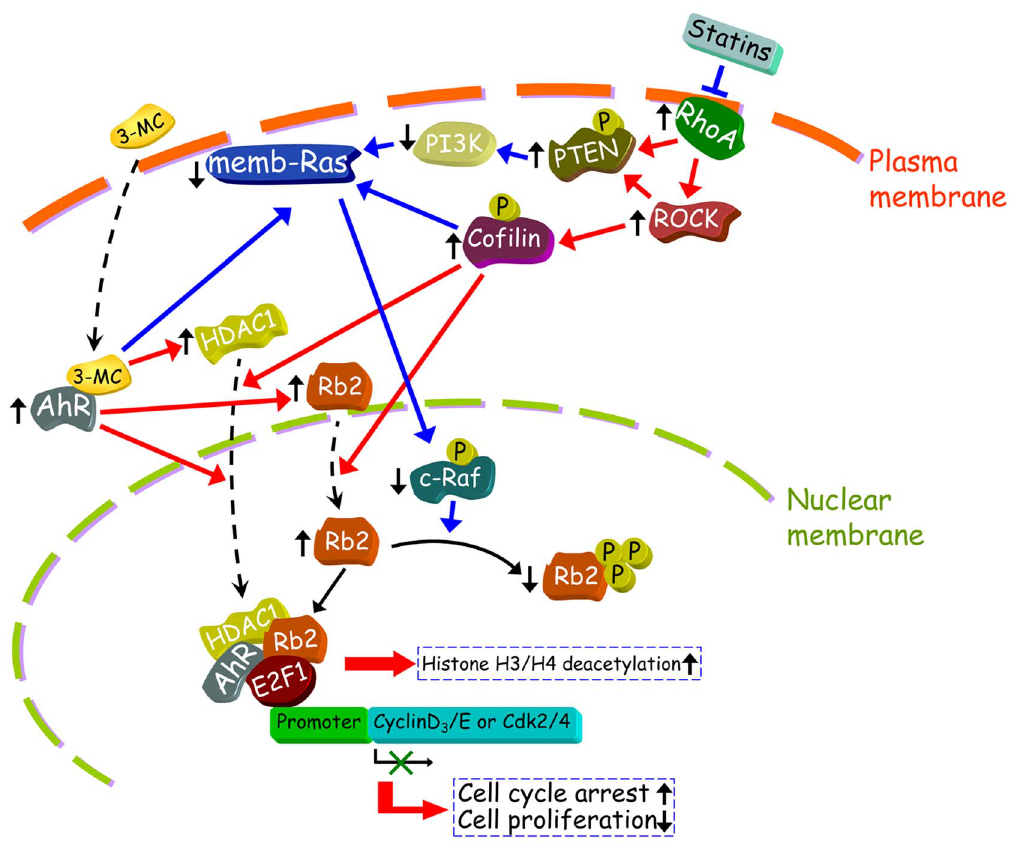
Figure 8. Summary of the signal pathways of 3MC on epigenetic modification of chromatin, resulting in MCVEC cell-cycle arrest. In the proposed signal pathways, 3MC-mediated AhR/RhoA activation modulates the PTEN/PI3K/Ras/c-Raf signaling pathways; this is followed by pRb2 hypophosphorylation, with a concomitant increase in HDAC1 upregulation and nuclear translocation. Treatment with 3MC also increased protein interaction within the E2F1 complex, including AhR, pRb2, and HDAC1. The downstream transcription factor E2F1 was negatively regulated by the co- repressor HDAC1, resulting in the downregulation of the cell-cycle regulatory proteins, including Cdk2/4 and Cyclin D3/E. Subsequently, DNA incorporation was decreased in MCVECs. The orange arrow lines indicate upregulation or activation of downstream molecules, whereas the blue lines represent downregulation or inactivation of the downstream targets. The signal pathways identified in this study are shown as solid lines with arrows, and proposed correlations are indicated by dashed lines with arrows. Additionally, the dashed-black lines indicate that the translocation occurs between cytosol and nuclei or between cytosol and the plasma membrane.